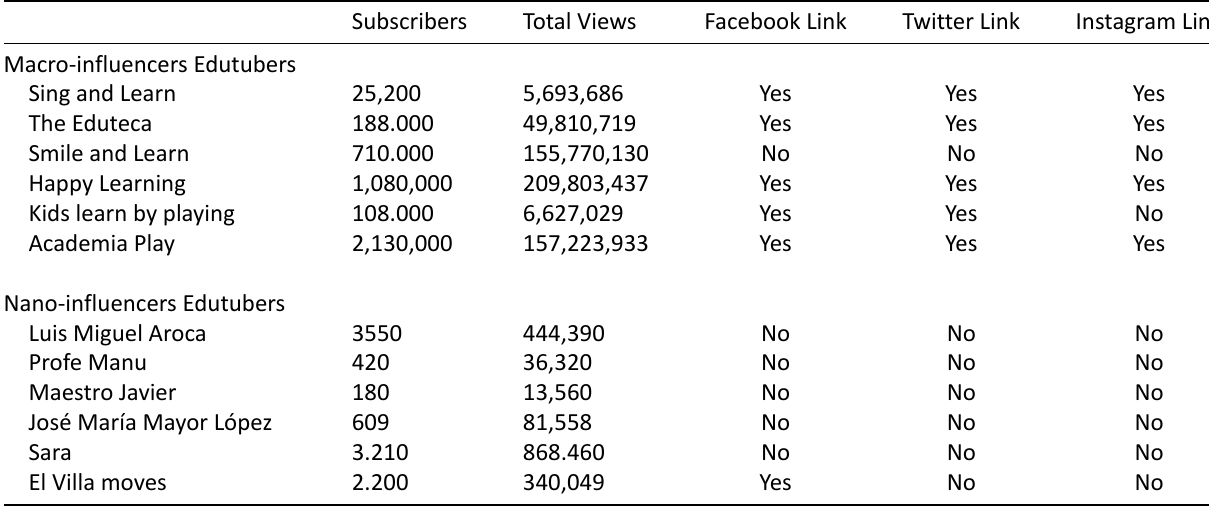
Table 5. Dissemination and impact of